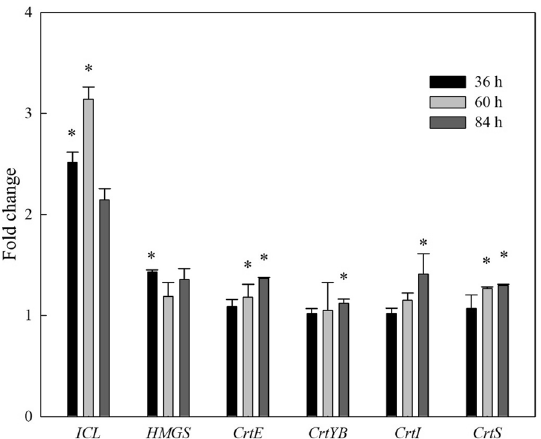
Fig. 6 Na-citrate regulates the transcriptional level of key genes involved in astaxanthin synthesis. The key genes include ICL (encoding isocitrate lyase), HMGS (encoding HMG-CoA synthase), crtE (encoding GGPP synthase), crtYB (encoding phytoene synthase/ lycopene cyclase), crtI (encoding phytoene dehydrogenase) and crtS (encoding astaxanthin synthase), where * represents statistical differences with P < 0.05 compared to the control. Values are means standard deviation of three independent ±